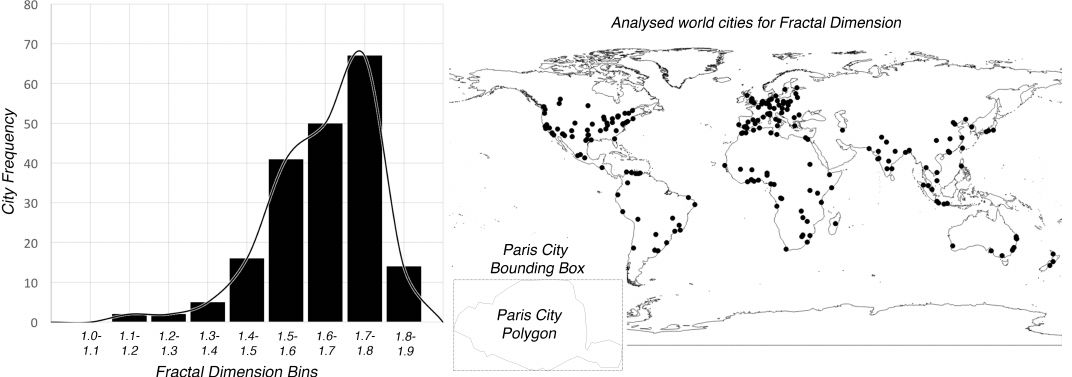
Figure 3. Histogram showing the frequency of cities (marked on the world map right ) for each Fractal-Dimension bin. Increase in the dimension represents an increase in the road-density. Three cities are selected from each of the top five bins to test all proposed search algorithms. Each city-polygon’s bounding box is used to download the corresponding XML data from OSM Overpass